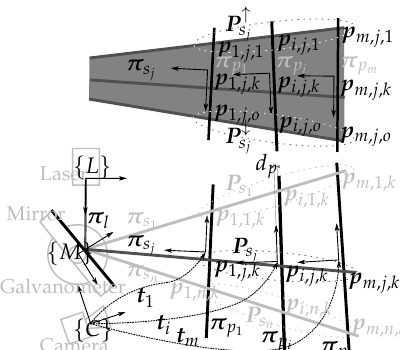
Figure 6. Illustration with all the elements from the air laser calibration. The top part of the figure shows the vertical view of the laser plane P s . The bottom part shows the top view of the laser scanner j and the calibration